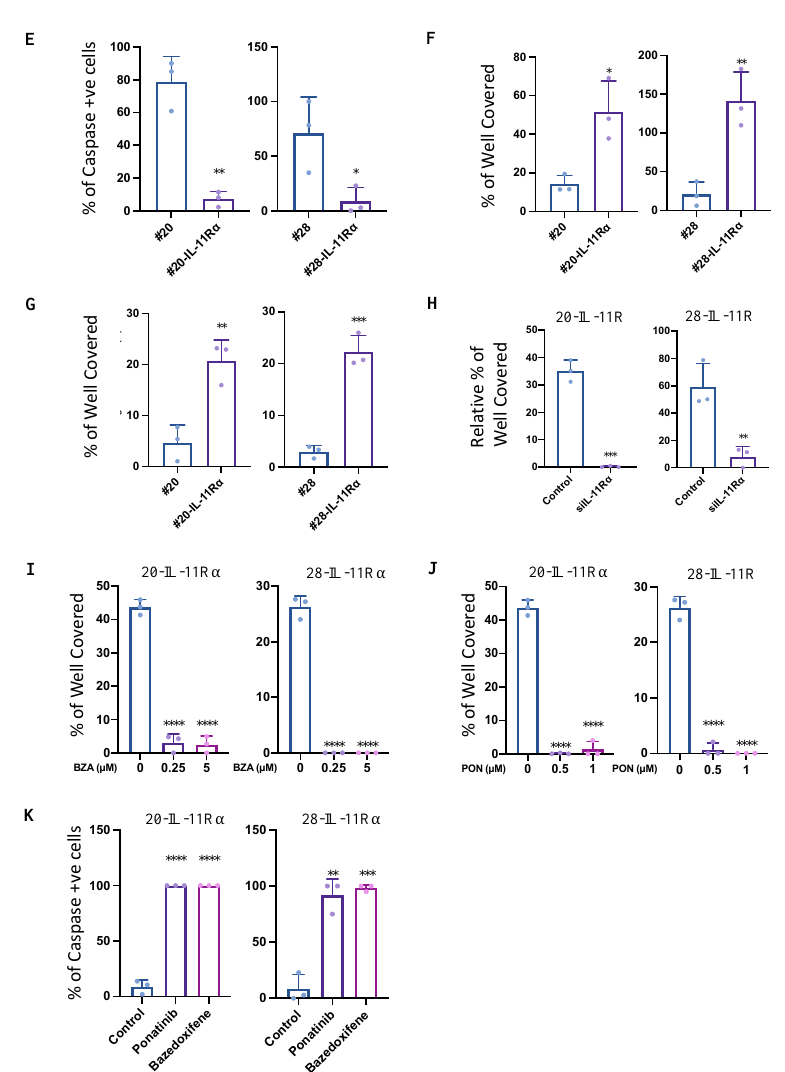
Figure 2. IL-11R α expression promotes survival in glucose-starved conditions. #20, #20-IL-11R α , #28 and #28-IL-11R α cells were serum-starved overnight, then assessed for ( A ) glucose oxidation (n = 6, mean ± SD, where ns indicates p > 0.05), ( B ) glutamine oxidation (n = 6, mean ± SD, where ** indicates p < 0.01 and *** indicates p < 0.001), and ( C ) glutamate production (n = 3, mean ± SD, where * indicates p < 0.05 and ** indicates p < 0.01). #20, #20-IL-11R α , #28 and #28-IL-11R α cells were cultured in glucose-free DME media ± glutamine and evaluated for ( D ) survival using the cell viability assay (n = 3, mean ± SD, where ** indicates p < 0.01 and *** indicates p < 0.001) and ( E ) percentage of apoptotic cells (active caspase3/7 fluorescence) (n = 3, mean ± SD, where * indicates p < 0.05 and ** indicates p < 0.01). #20, #20-IL-11R α , #28 and #28-IL-11R α cells were cultured in media containing both glucose and glutamine and treated with ± ( F ) 2-DG or ( G ) Lopinavir for 48 h. Survival was evaluated using the cell viability assay (n = 3, mean ± SD, where * indicates p < 0.05, ** indicates p < 0.01 and *** indicates p < 0.001). #20-IL-11R α and #28-IL-11R α were ( H ) transfected with control or IL-11R α siRNA or treated with ( I ) Ponatinib or ( J ) Bazedoxifene and then cultured in glucose-free media containing glutamine for 48 h. Survival was evaluated using the cell viability assay (n = 3, mean ± SD, where ** indicates p < 0.01, *** indicates p < 0.001 and **** indicates p < 0.0001) ( K ) #20-IL-11R α and #28-IL-11R α were treated with Ponatinib or Bazedoxifene and then cultured in glucose-free media containing glutamine for 48 h before the percentage of apoptotic cells (active caspase3/7 fluorescence) was determined (n = 3, mean ± SD, where ** indicates p < 0.01, *** indicates p < 0.001 and **** indicates p <